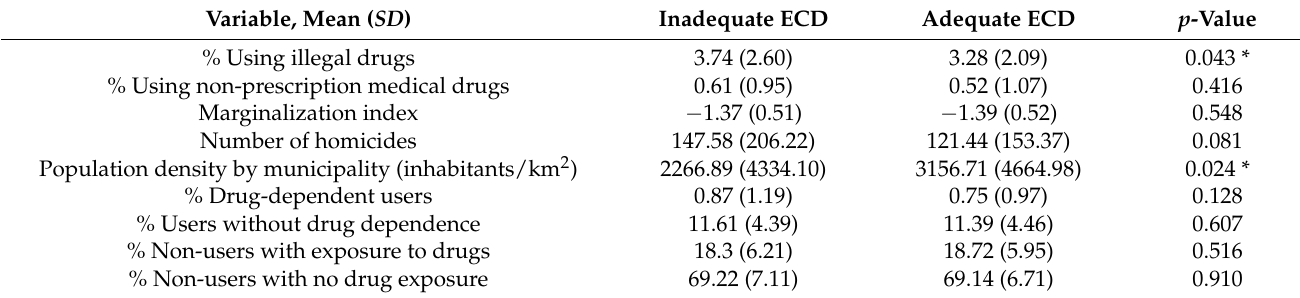
Table 2. Prevalence of psychoactive substance use and environmental characteristics of the municipalities where children with inadequate or adequate early childhood development